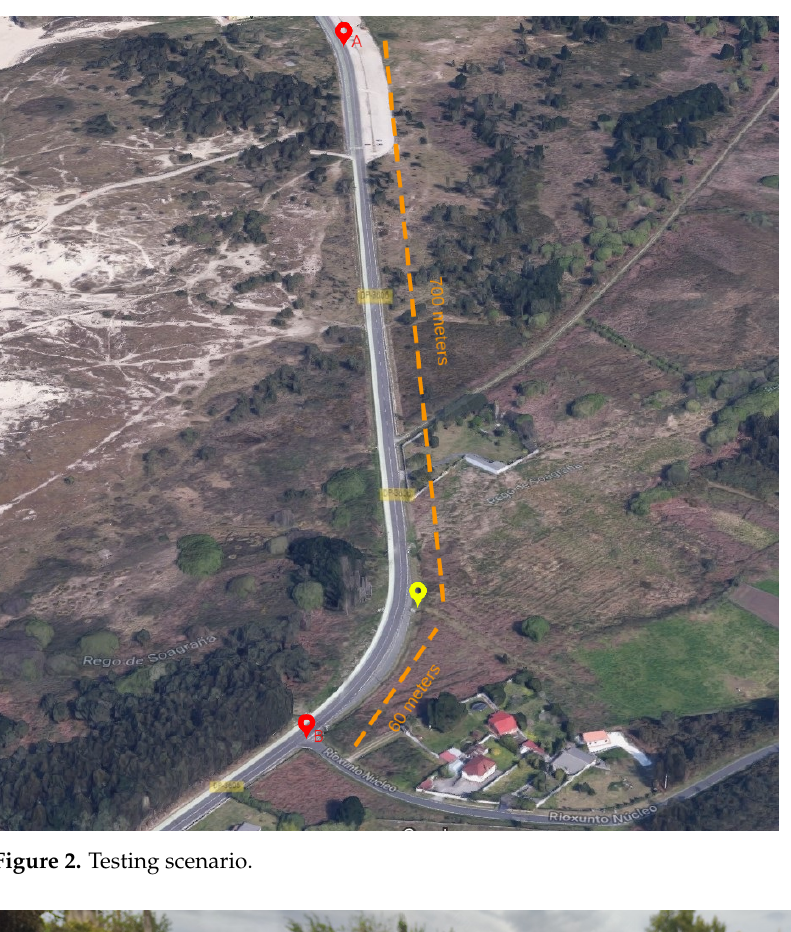
Figure 2. Testing scenario.